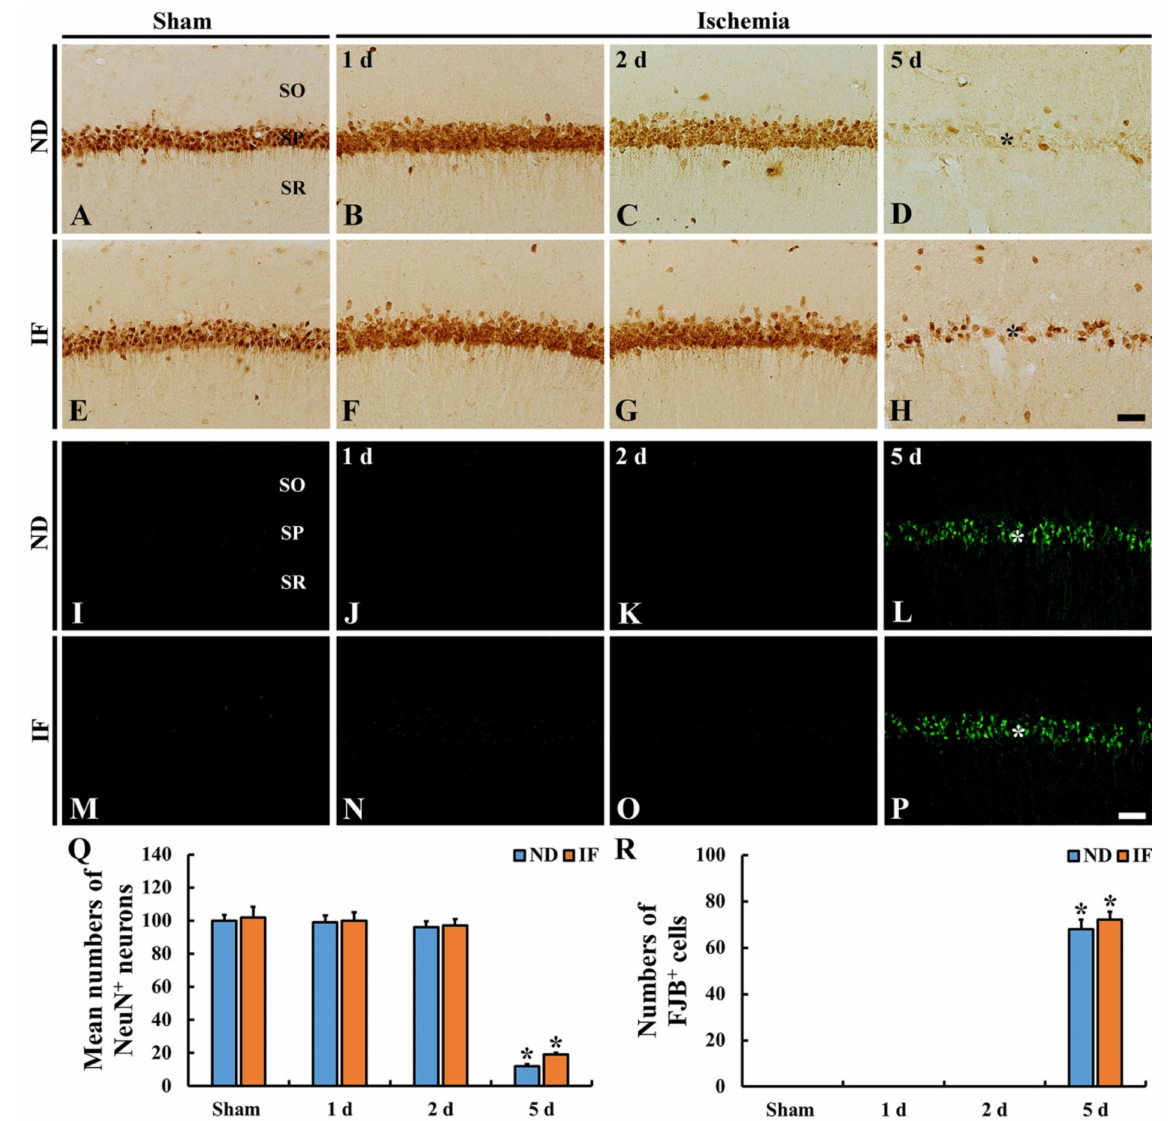
Figure 5. Neuronal nuclei antigen (NeuN) immunohistochemistry ( A – H ) and fluoro-Jade B (FJB) fluorescence staining ( I – P ) in the CA1 region of the ND and IF groups at sham ( A , E , I , M ), 1 day ( B , F , J , N ), 2 days ( C , G , K , O ) and 5 days ( D , H , L , P ) after ischemia. The NeuN immunoreactive pyramidal neurons in both of the groups show immunoreactivity until 2 days post-ischemia; however, at 5 days post-ischemia, few NeuN immunoreactive pyramidal neurons (asterisk) are shown in both of the groups. In addition, in both of the groups, numerous FJB-positive neurons are shown in the stratum pyramidale (SP) at 5 days post-ischemia. Scale bar = 50 µ m. ( Q , R ) Mean numbers of NeuN immunoreactive ( Q ) and FJB-positive ( R ) cells in 250 µ m 2 at the center of the CA1 region ( n = 7 in each group, * p < 0.05 vs. ND/sham group by post hoc Tukey’s test). Bars indicate the means ± SEM. IF, intermittent fasting; ND, normal diet; SO, stratum oriens; SR, stratum